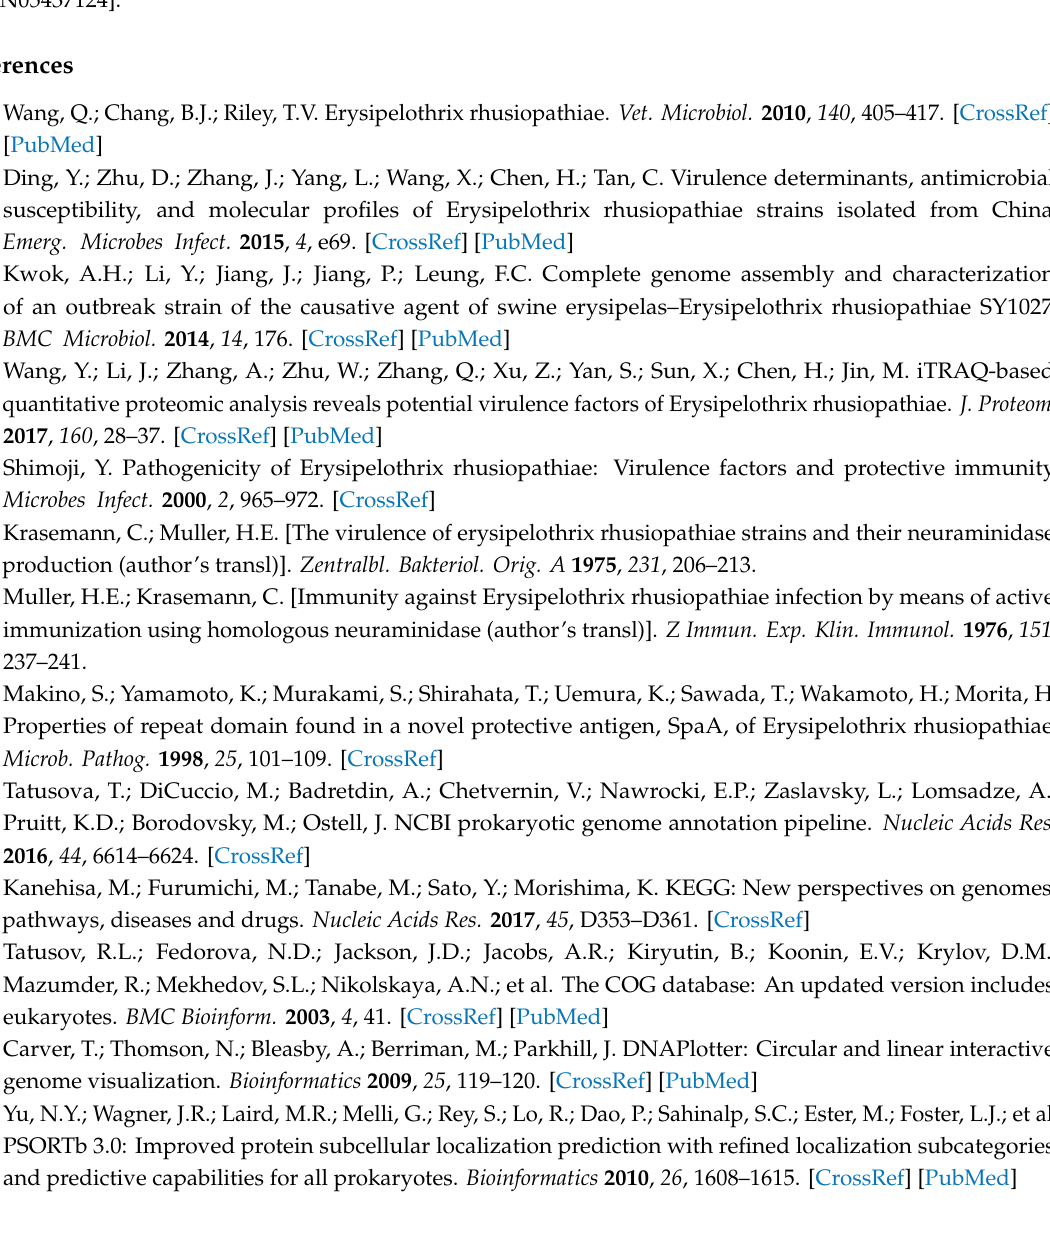
Table S1 Predicted functions of the virulence factors coding genes